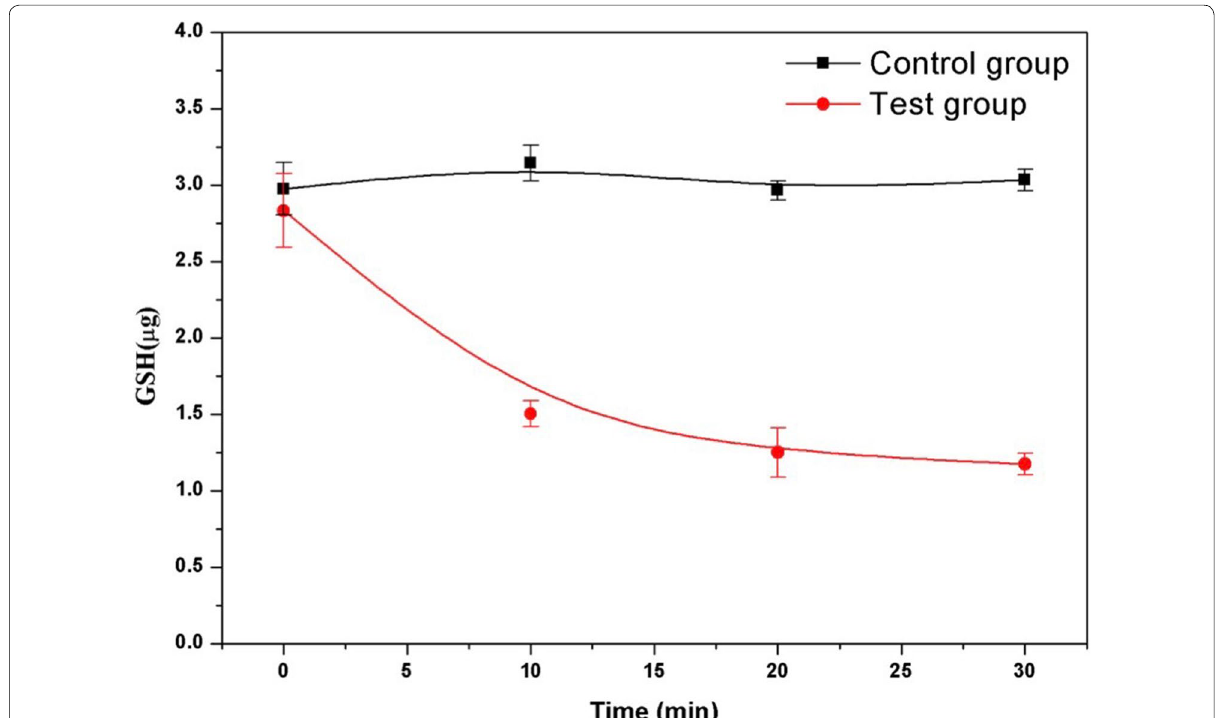
Fig. 2 GSH changes with time in the presence of purified LigF. In this part, the total volume of reaction mixture was 5 mL, the test group